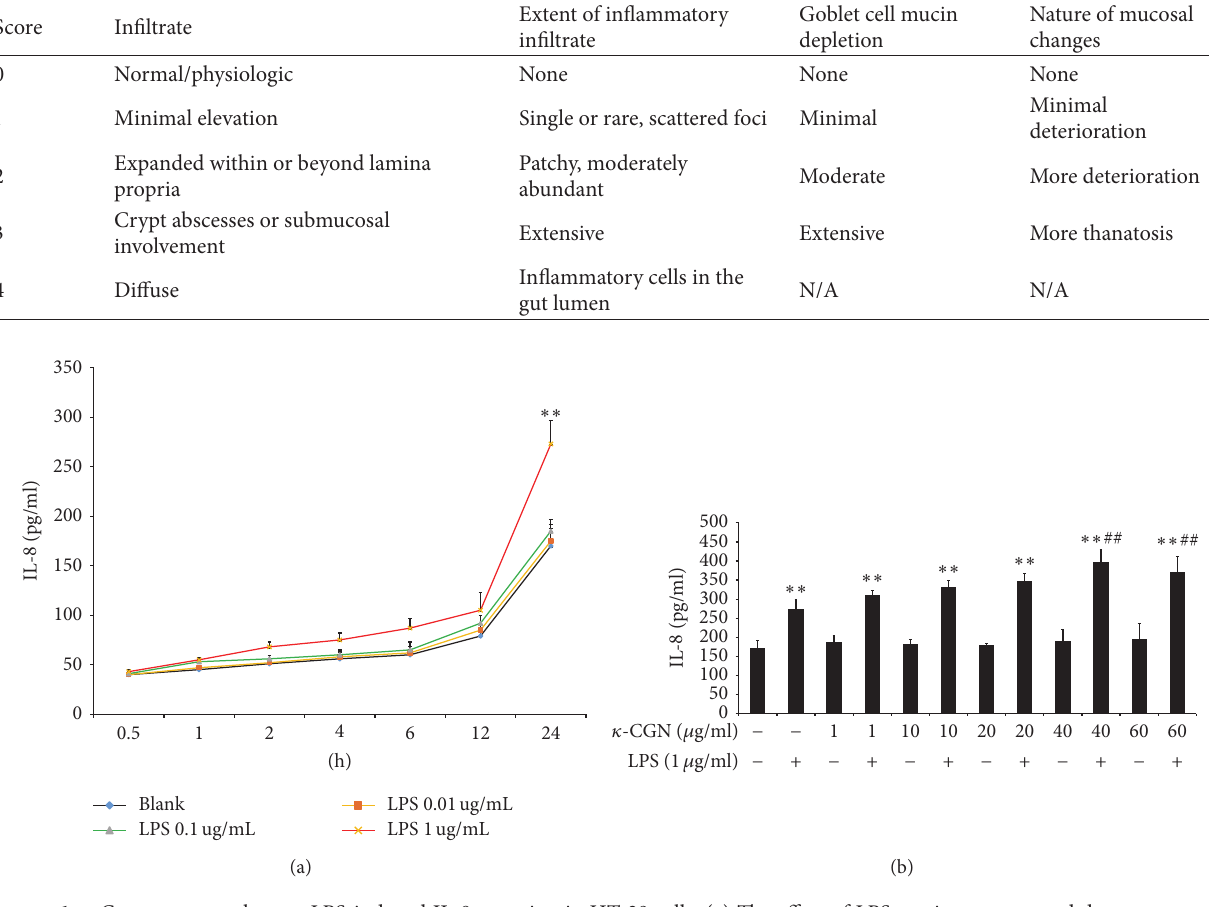
Figure 1: 𝜅 -Carrageenan enhances LPS-induced IL-8 secretion in HT-29 cells. (a) The effect of LPS on time-course and dose-response in HT-29 cells. (b) 𝜅 -Carrageenan increased LPS-induced expression of IL-8. IL-8 expression was assessed by ELISA in HT-29 cells treated with or without different concentrations of LPS (0.01, 0.1, and 1 𝜇 g/mL) for 0.5 h, 1h, 2 h, 4h, 6h, 12h, and 24h or treated with 𝜅 -carrageenan at the indicated doses in the absence or presence of 1 𝜇 g/mL LPS. ∗∗ 𝑃 < 0.01 , compared with the blank group. ## 𝑃 < 0.01 , compared with the LPS treated